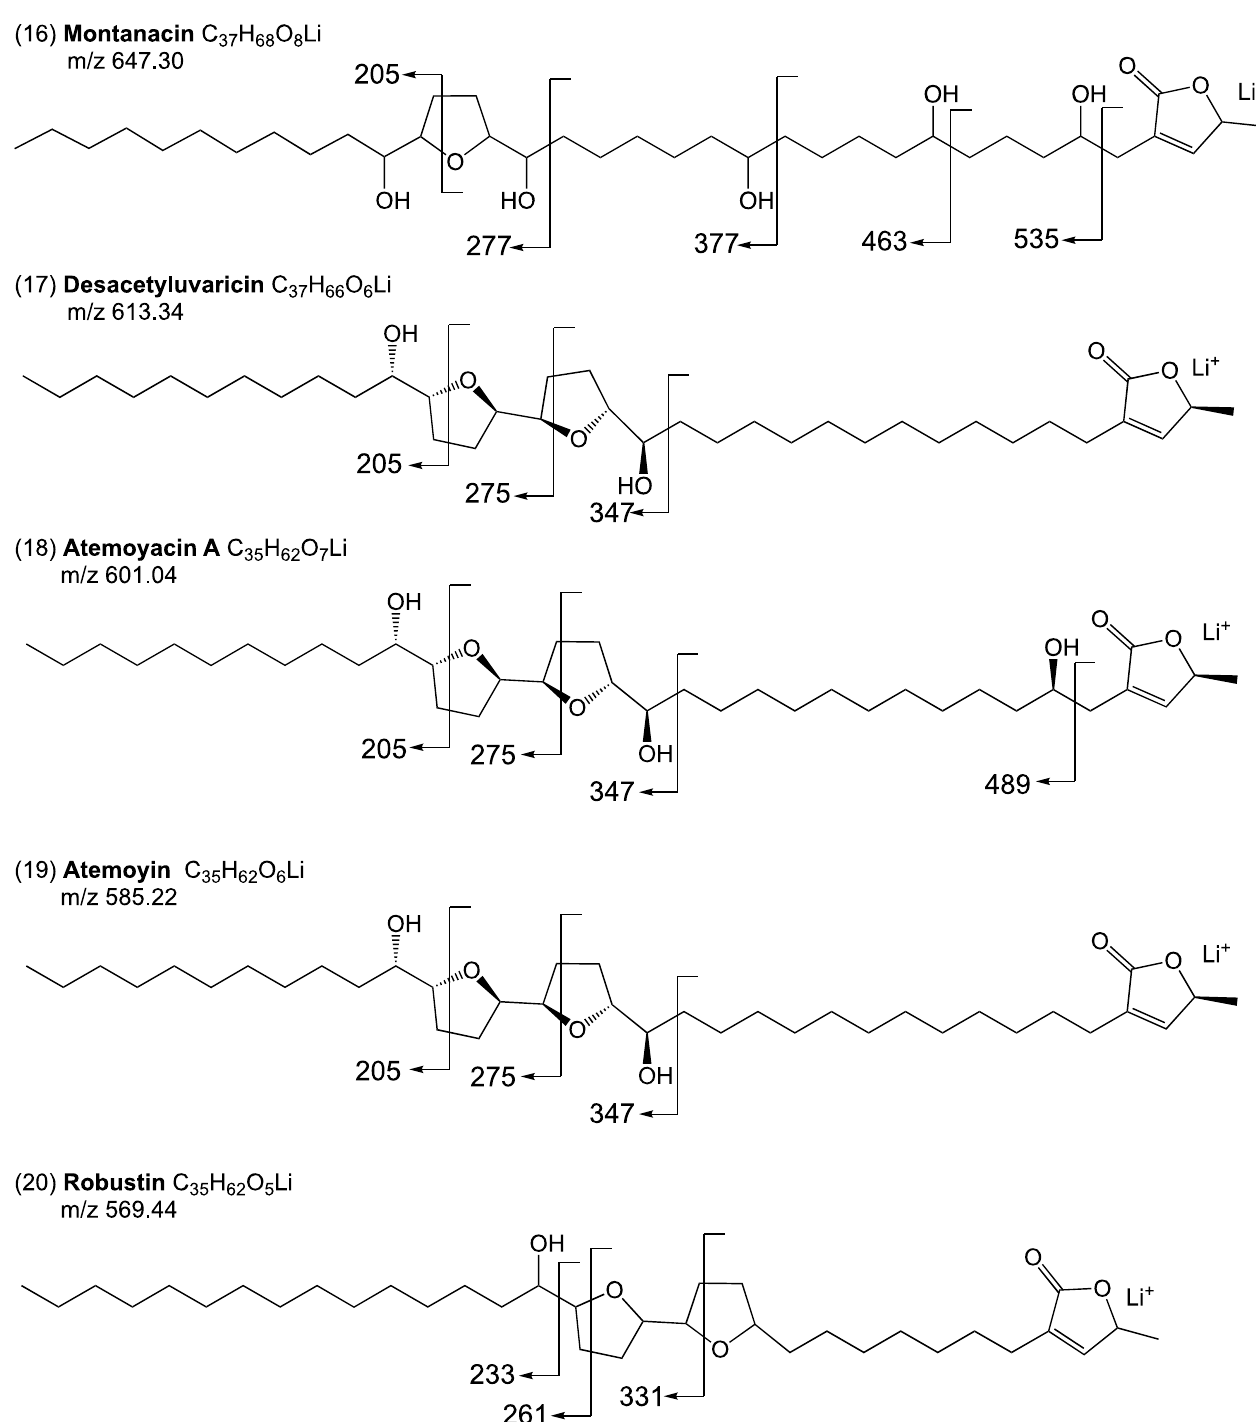
Figure 1. Structures and fragmentation patterns for the [M + Li] + adducts of acetogenins and alka- loids identified in the leaves, pulp, and seeds of A. atemoya